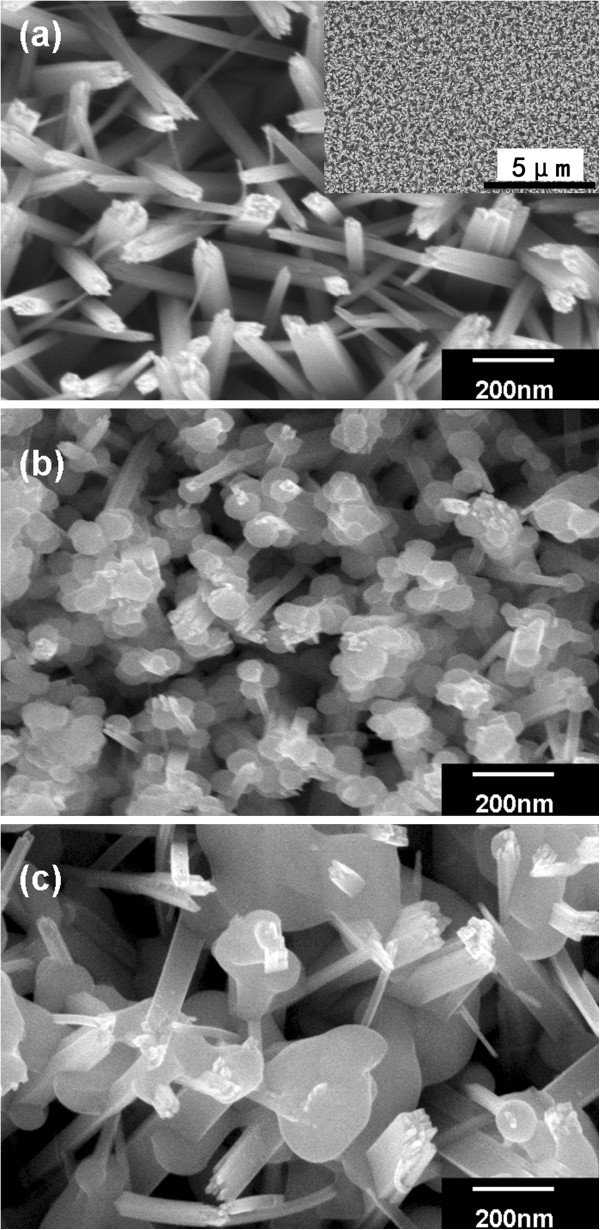
Typical top-view SEM images of TiO2 nanorod arrays and Sb2S3-TiO2 nanostructures. (a) SEM image of a TiO2 nanorod array grown on SnO2:F substrate by hydrothermal process. Inset: A low-magnification SEM image of the same sample. (b) SEM image of the as-grown Sb2S3-TiO2 nanostructures. (c) SEM image of Sb2S3-TiO2 nanostructures annealed at 300°C for 30 min.